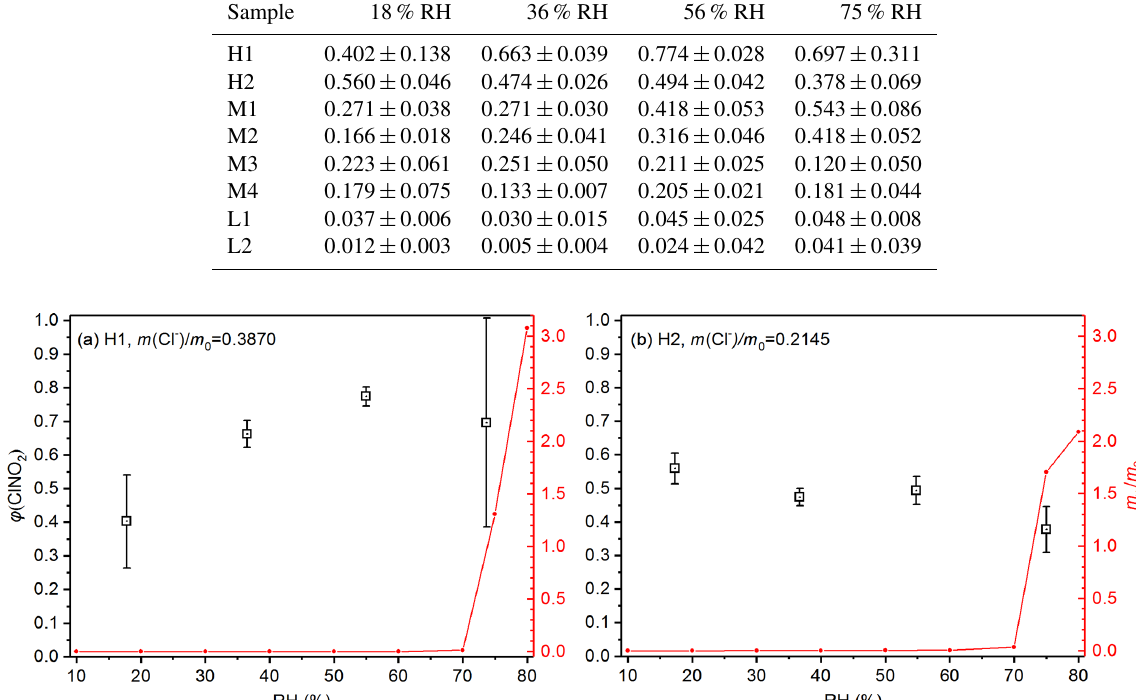
Figure 3. Measured ClNO 2 yields (black symbol) and m w /m 0 (red line) as a function of RH for (a) H1 and (b) H2. The error bar represents standard deviation, and m w /m 0 represents the normalized mass of particulate water (normalized to the mass of dry particles), which was measured as the relative increase in particle mass at a given RH compared to < 1%